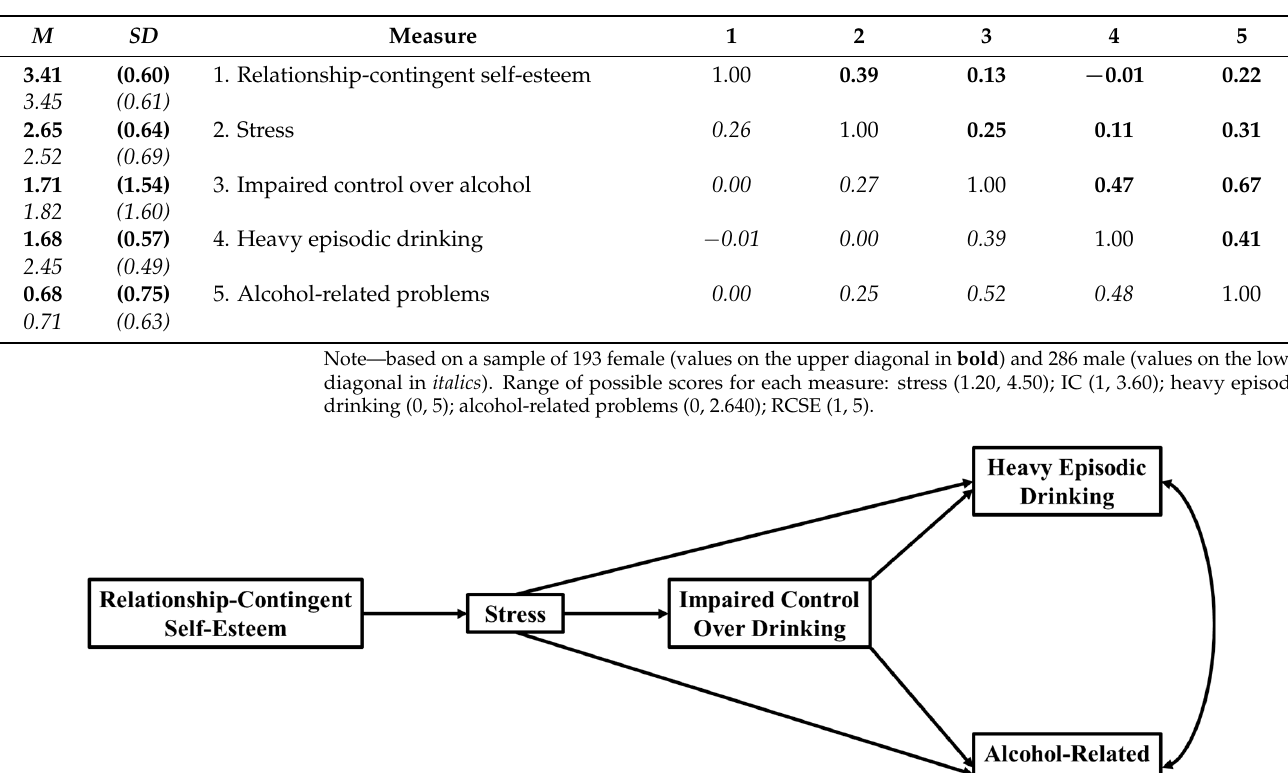
Table 2. Means, standard deviations, and correlations among all variables in the model.